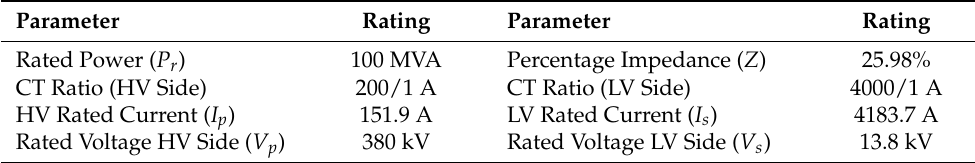
Table 1. Technical nameplate details for the power transformer at the Shoaiba